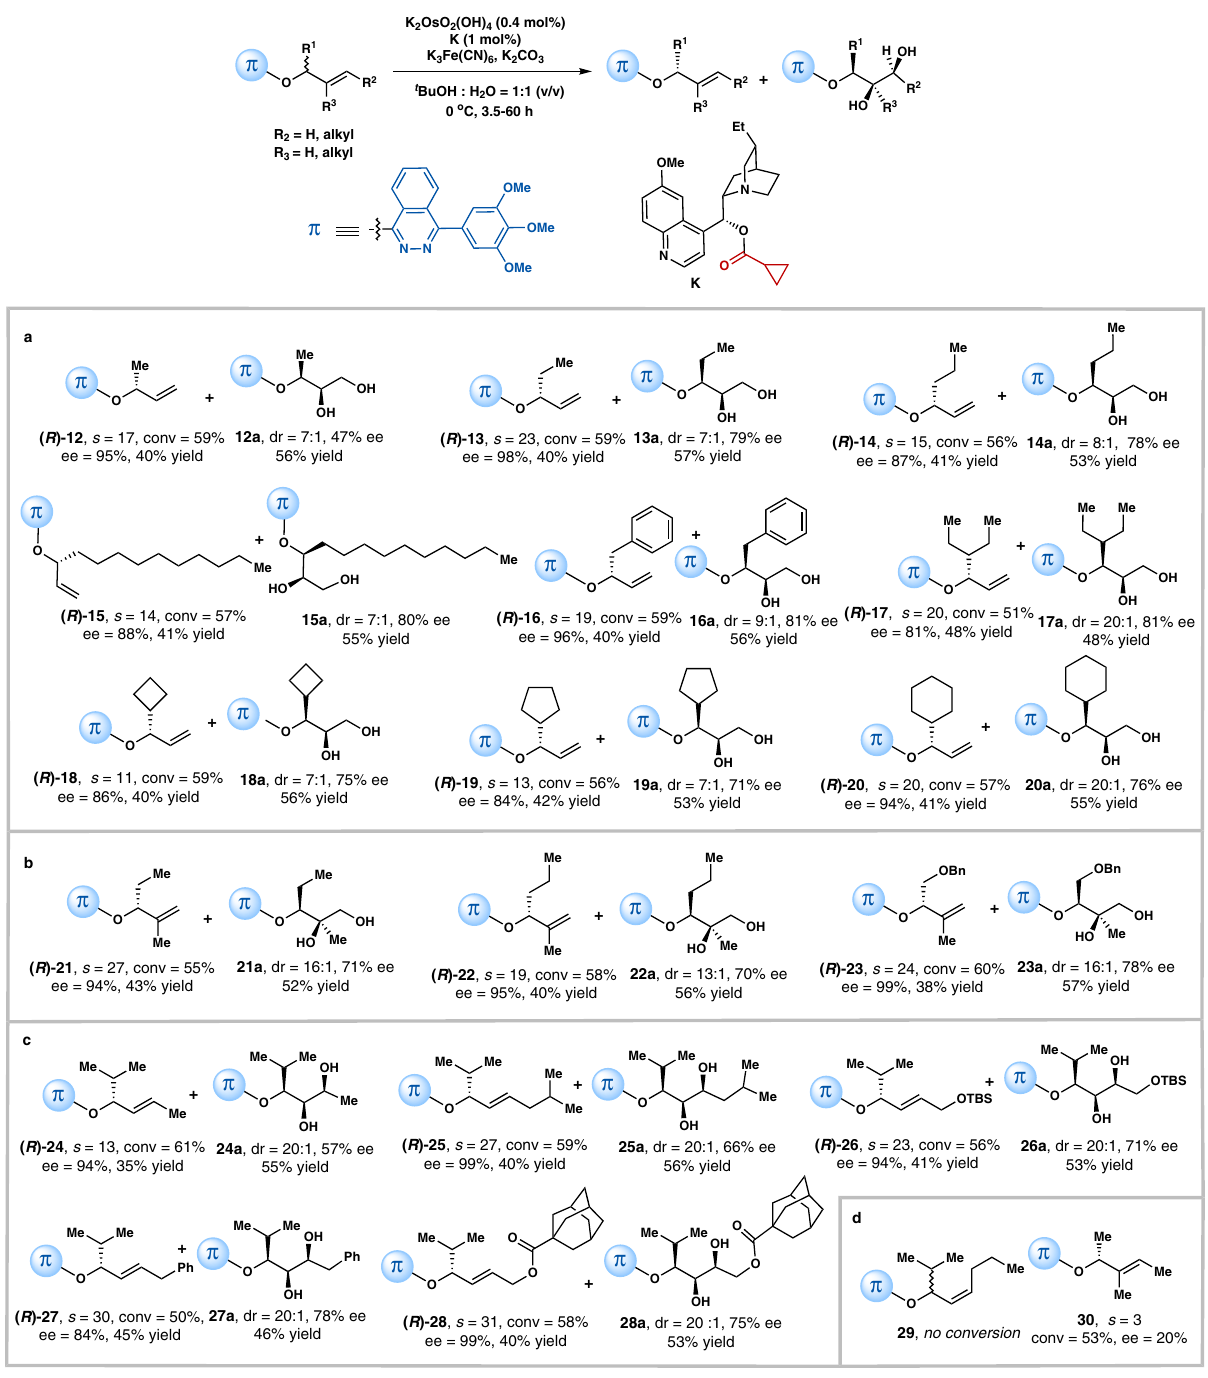
Fig. 5 Scope for AD-based kinetic resolution controlled by the lone-pair – π interaction. a Racemic substrates with mono-substituted terminal alkenes. b Racemic substrates with 1,1-disubstituted terminal alkenes. c Racemic substrates with 1,2-( E )-disubstituted alkenes. d Unsuccessful substrates. General condition: K 2 OsO 2 (OH) 4 (0.4 mol%), K 3 Fe(CN) 6 (3.0 equiv), K 2 CO 3 (3.0 equiv), ligand K (1.0 mol%) and allylic ether (0.1 mmol) in 1.0 mL t BuOH-H 2 O (v/v = 1:1), 0 °C. Conversion (conv) and diastereomeric ratio (dr) were determined by 1 H NMR analysis of the crude mixture. Isolated yields were given. stereoselectivity (Fig. 4c). The π – π interaction is relatively strong of the ligand and the phthalazine moiety of the substrate is evi- in its magnitude ( − 8.1 kcal/mol), which may contribute to denced clearly by the short distances of the carbonyl oxygen to the binding of substrate with the catalyst but plays a much the centroid of and to the plane of the diazine ring (2.94 Å and smaller role in controlling the stereoselectivity, as both TSs 2.87 Å, respectively) 25,53 . However, this type of interaction is absent in the disfavored transition state TS-( R ), which may have such an interaction in a similar magnitude. To unravel the contribute to the difference in energy of these two TSs. Further nature of the lone-pair – π interactions, we performed energy calculations using truncated model show that the lone-pair π decomposition analysis (EDA) (Fig. 4c, center box) to separate Δ E − 3.1 kcal/mol) into chemically meaningful energy terms, interaction is − 3.1 kcal/mol, which is the main contributor to the int ( NATURE COMMUNICATIONS| (2022) 13:3276